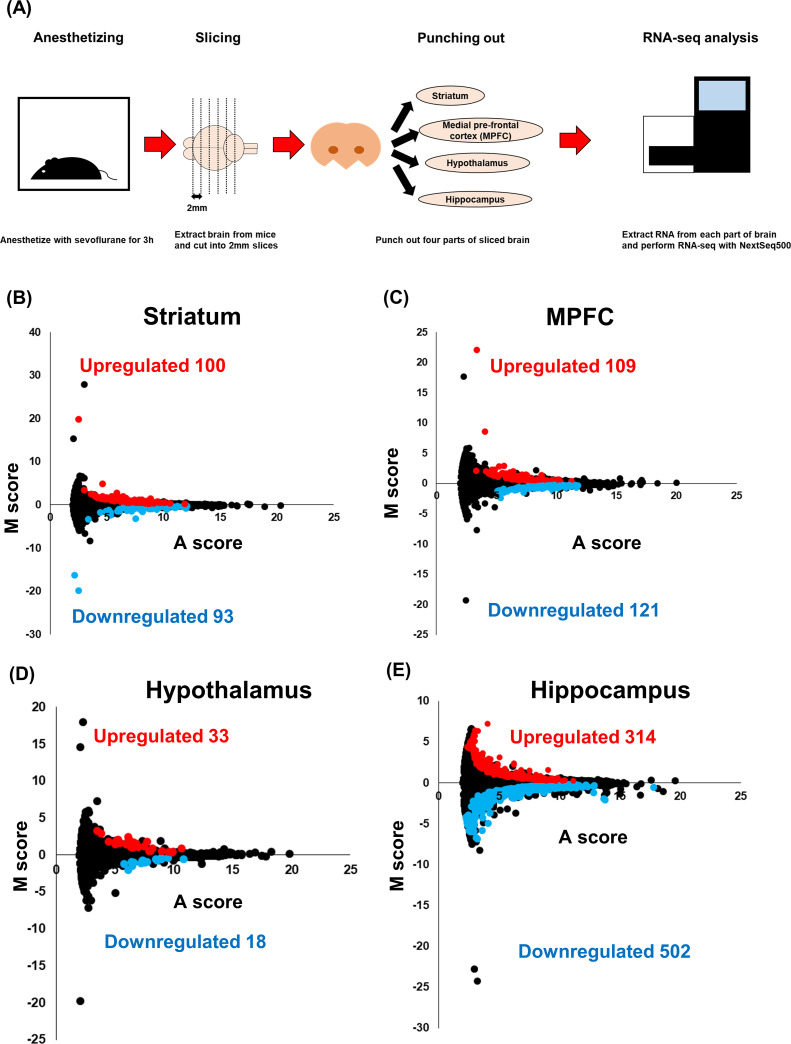
RNA-seq analysis for brains exposed to sevoflurane.(A)The workflow of the RNA-seq analysis for the anesthetized mice. After anesthetizing with 2.5% of sevoflurane and 40% oxygen for 3 hours, the brains were removed and sliced into 2 mm pieces. The striatum, medial prefrontal cortex (MPFC), hypothalamus and hippocampus were punched out. RNA was extracted from the punched out samples and RNA-seq was performed using NextSeq500.